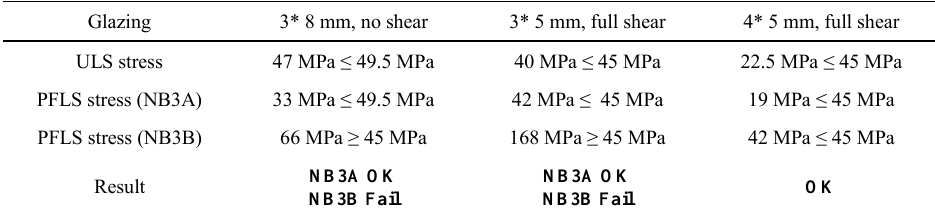
Table 2: Stress calculation for simplified barrier glazing